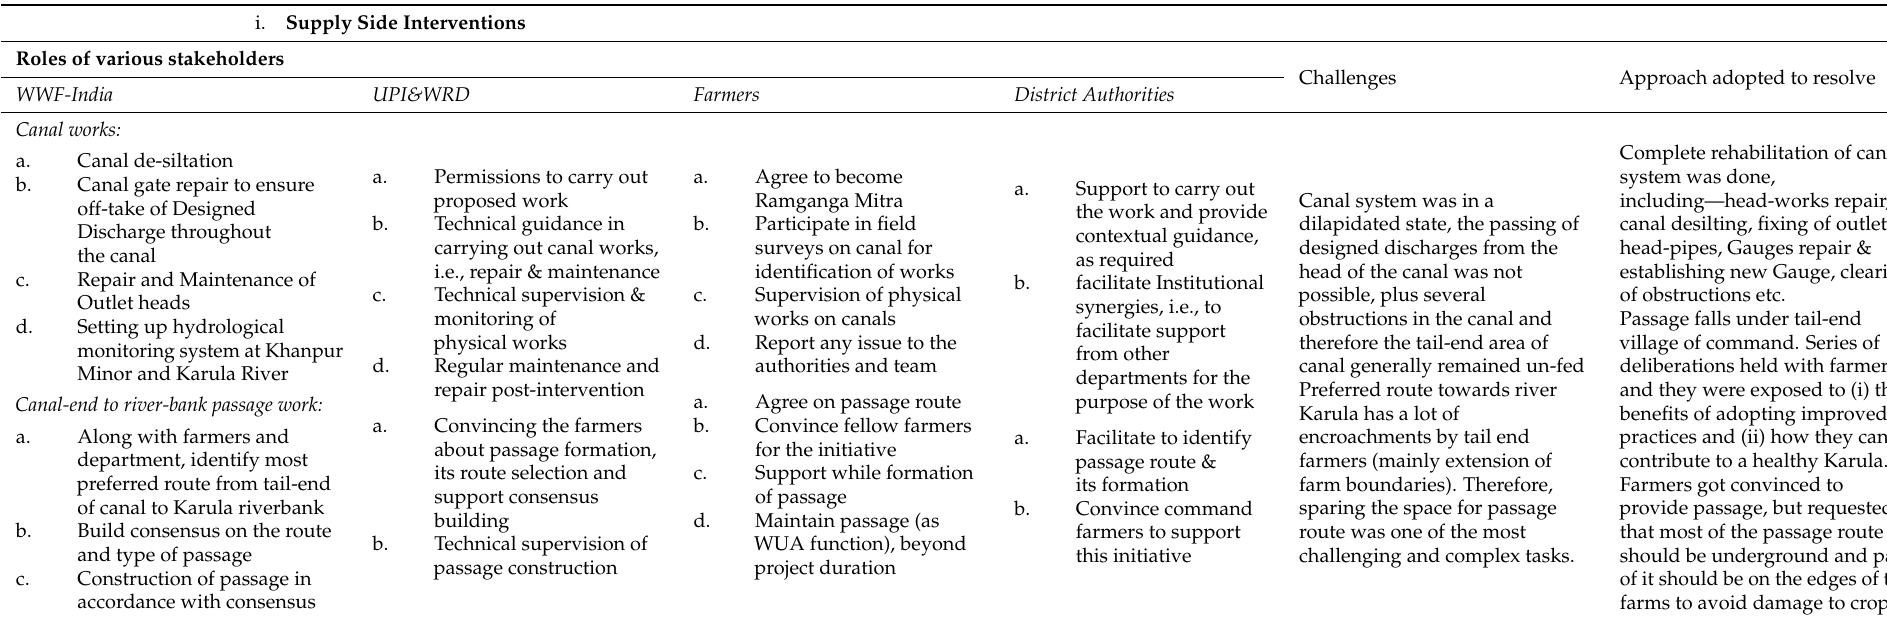
Table 2. Summary of roles, challenges and approach for this